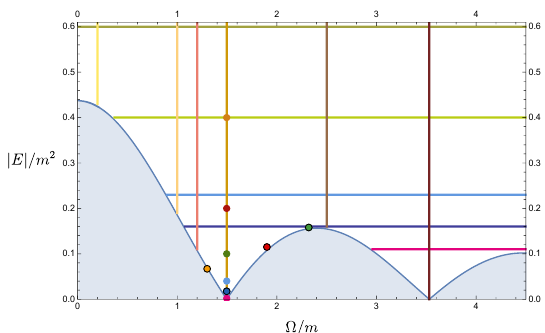
Figure 12 . The dots and circles signal the points where the AC conductivities in (cid:12)gures 10 and 11 have been plotted respectively. Also shown are the lines with either (cid:10) =m or j E j =m 2 (cid:12)xed, used to plot the DC conductivities in (cid:12)gures 13 and 14. In all cases, the same color code has been